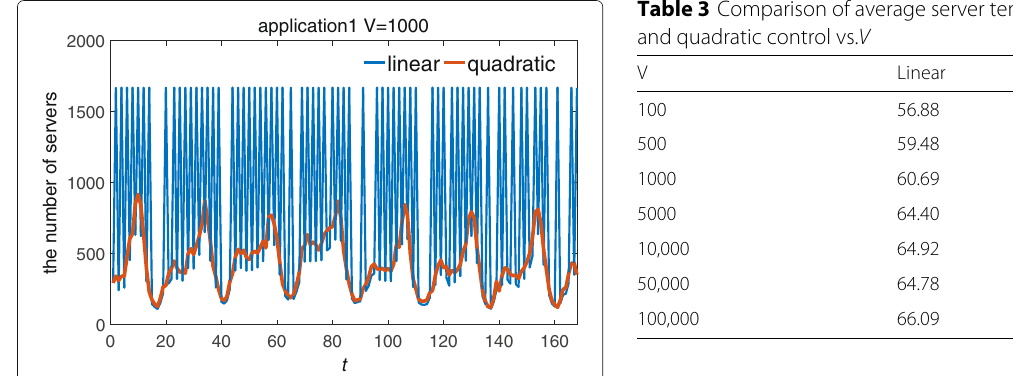
Average server temperature